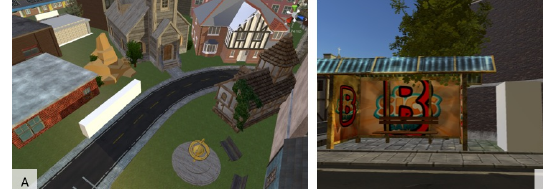
Figure 7: Size relations in Unity. (A) 10x2x1 Units cube. (B) 1x2x1 Units cube standing next to a bus stop. This is also the size of the